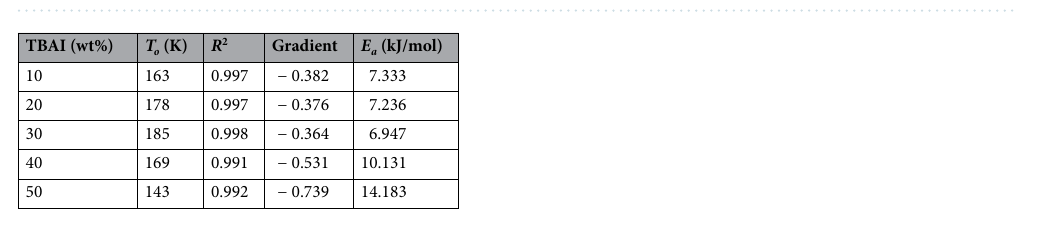
Table 3. T o , R 2 , gradient and E a for PUA-TBAI-I 2 gel electrolyte